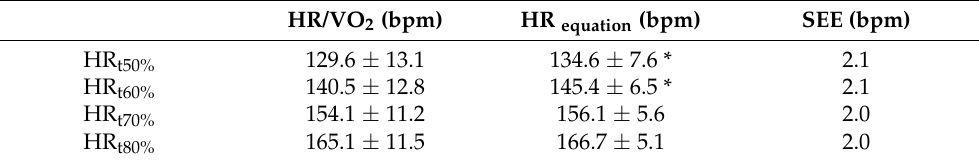
Table 5. Estimated values for the intensities of 50, 60, 70 and 80% of aerobic training compared to reference values (HR/VO 2 ) for individuals of both sexes in the cross-validation group (CVG). HR/VO 2 (bpm) HR equation (bpm) SEE (bpm) HR